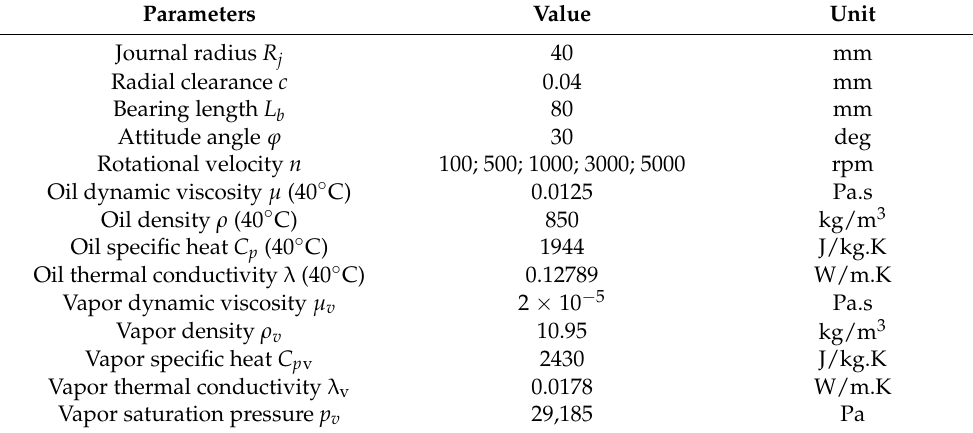
Figure 1. Schematic diagram of a heterogeneous slip/no-slip journal bearing. Table 1. Parameters of the